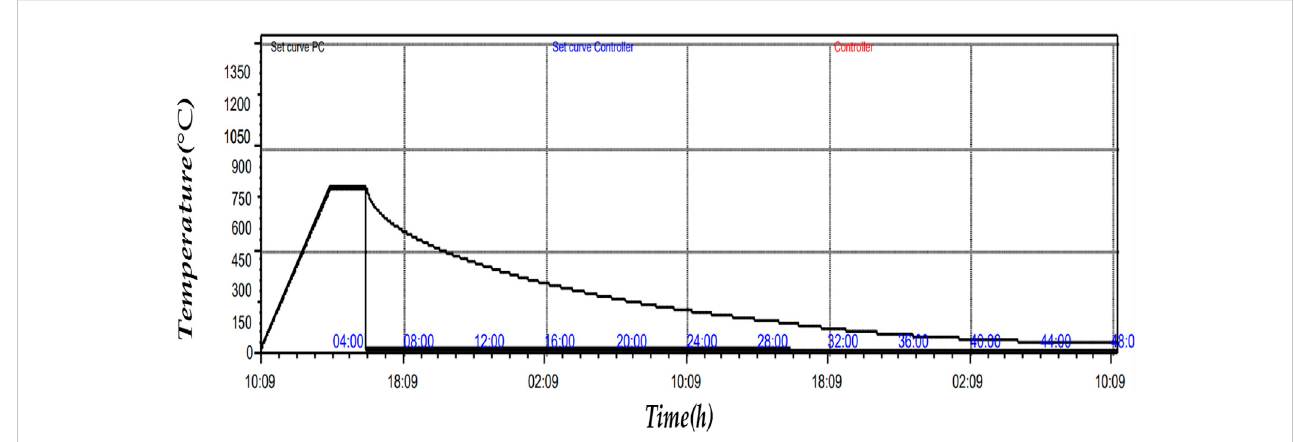
FIGURE 1 Temperature and times for the diffusion annealing process.